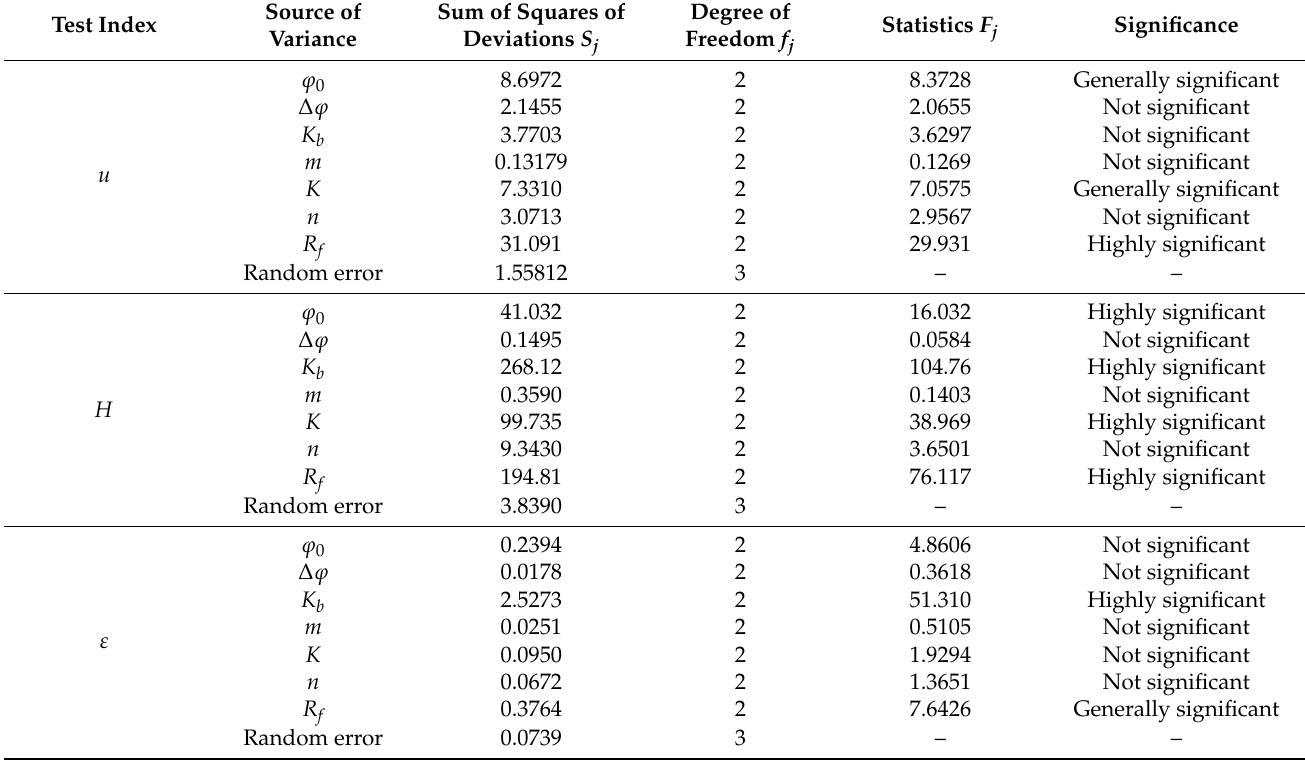
Table 11. ANOVA results of influencing factors of each test index for the main rockfill